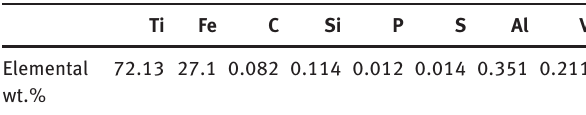
Table 1: Chemical composition of